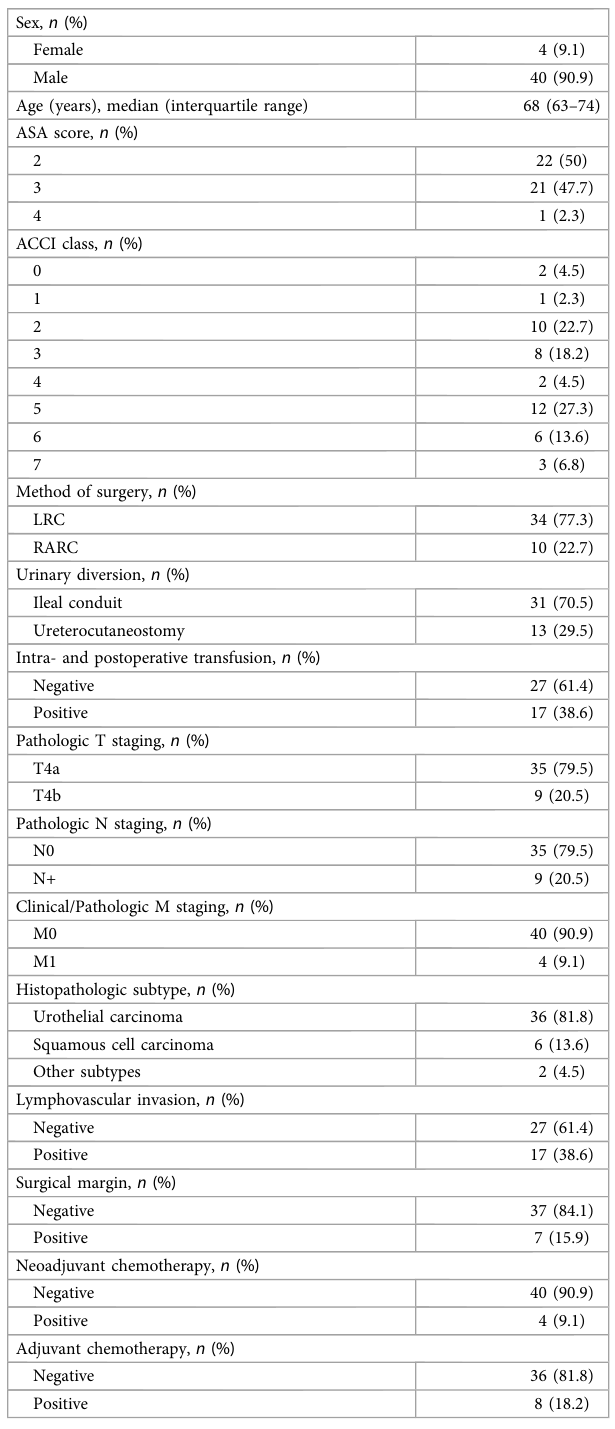
TABLE 1 Baseline clinicopathologic